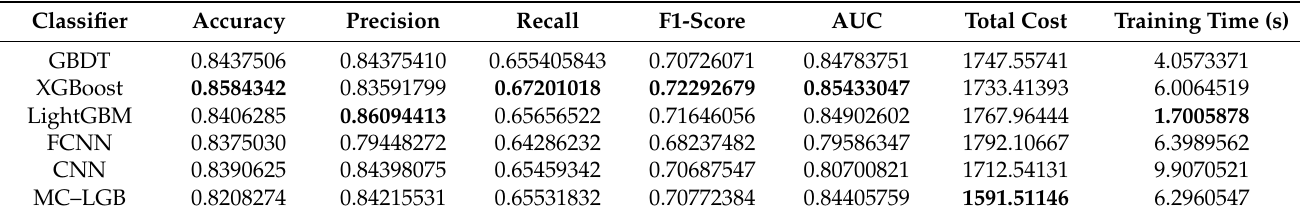
Table 5. Accuracy, precision, recall, F1-score, MCC, AUC, and training time of classifiers on the KPG dataset.